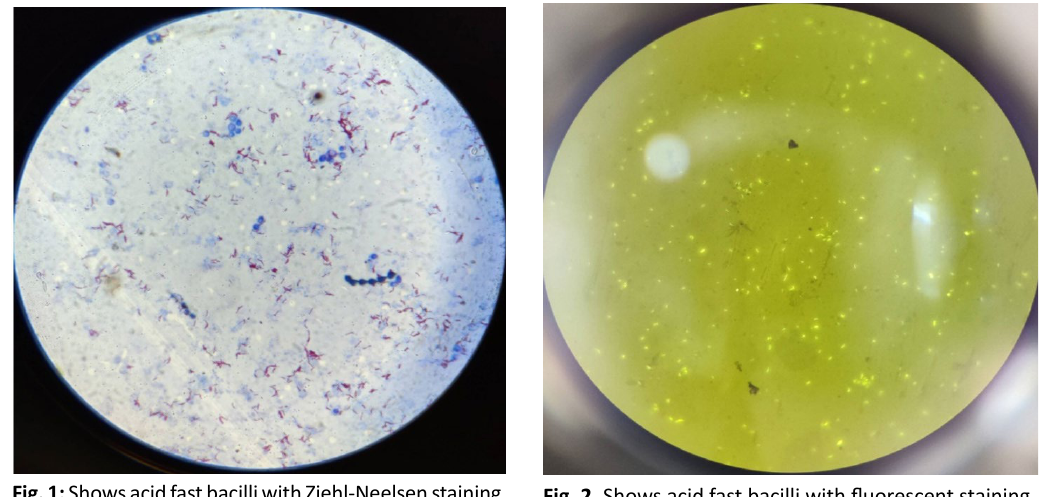
Fig. 1: Shows acid fast bacilli with Ziehl-Neelsen staining. Fig. 2. Shows acid fast bacilli with fluorescent